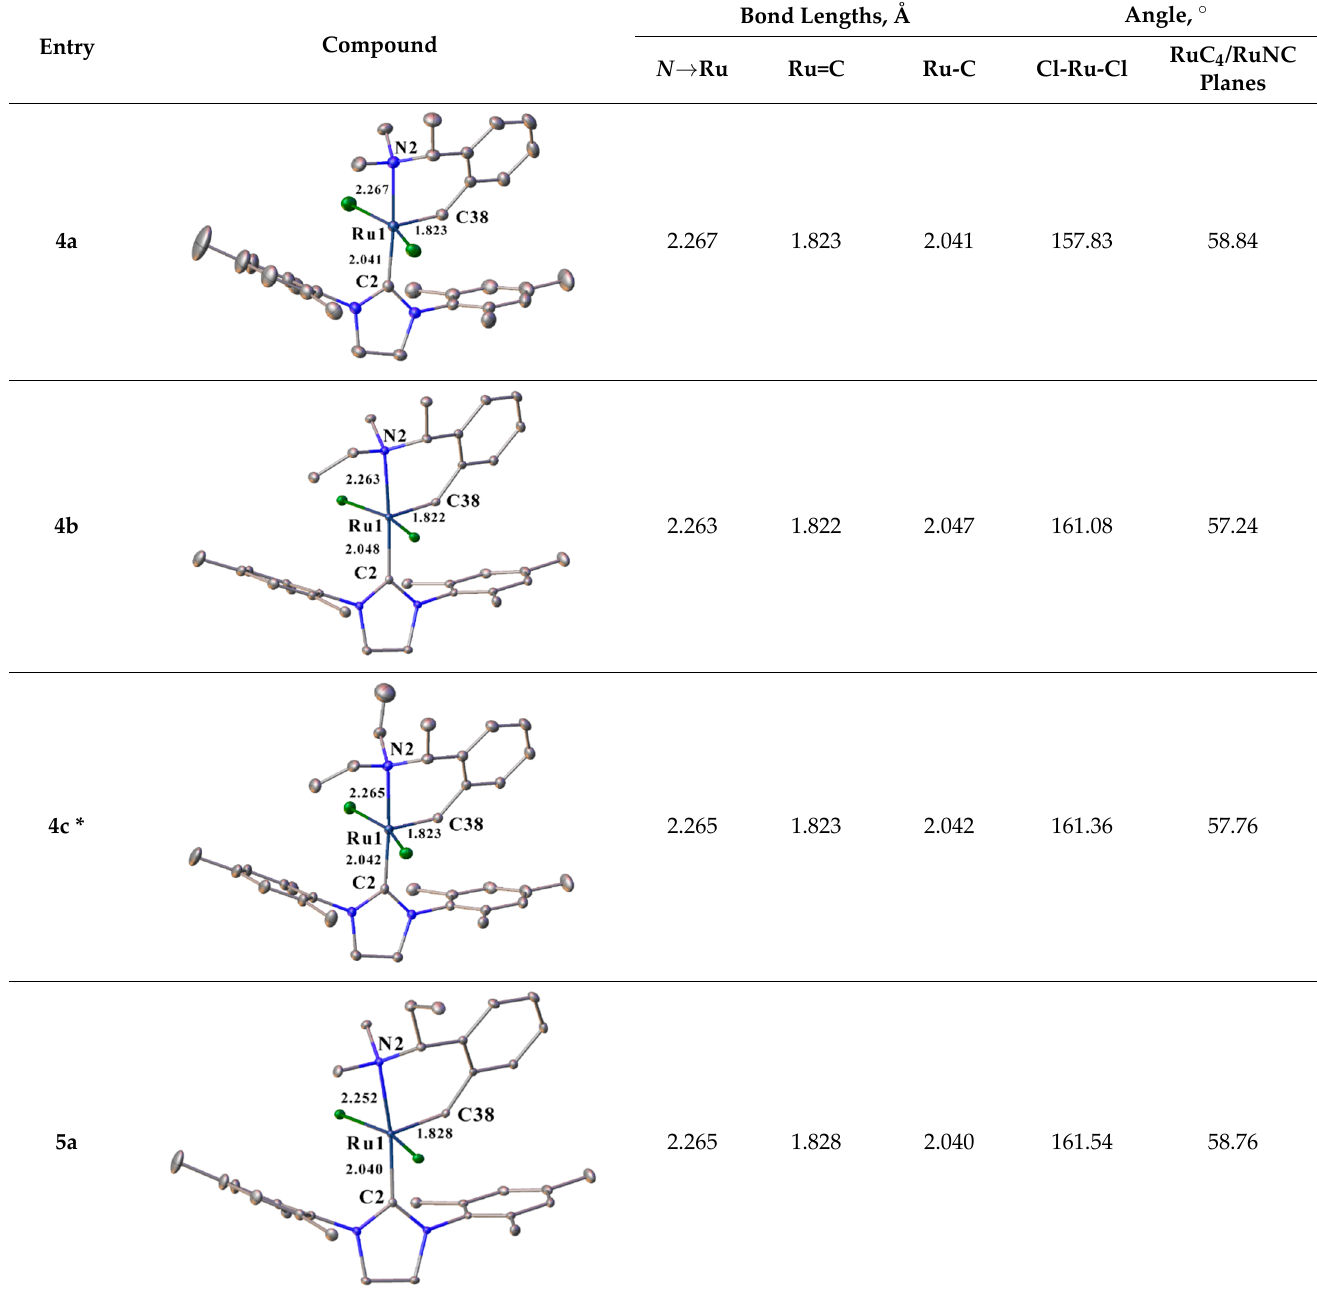
Table 3. Selected X‑ray data for ruthenium complexes 4a – c and 5a , b , d . Table 3. Selected X-ray data for ruthenium complexes 4a – c and 5a , b , d . Table 3. Selected X-ray data for ruthenium complexes 4a – c and 5a , b , d